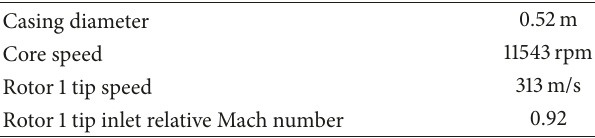
Figure 1: Meridian view of CREATE and measurement planes.